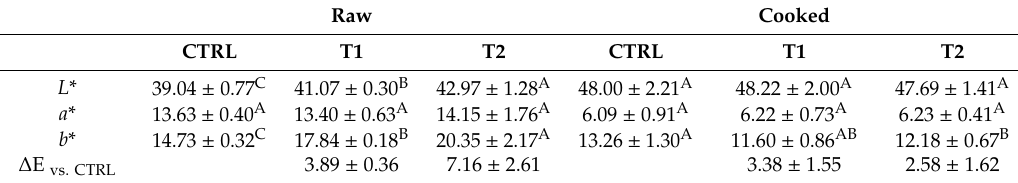
Table 5. Instrumental color determination of the beef burger without fat substitution (CTRL) and at 50% (T1) and 100% (T2) of fat substitution with an oat-hull-based gel before (Raw) and after (Cooked) cooking. Raw Cooked CTRL T1 T2 CTRL T1 T2 L * 39.04 ± 0.77 C 41.07 ± 0.30